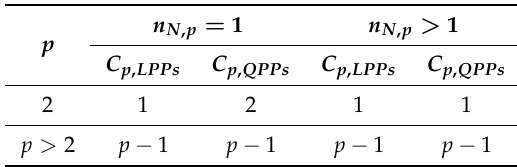
, with n N , p ≥ 1. p nN , p